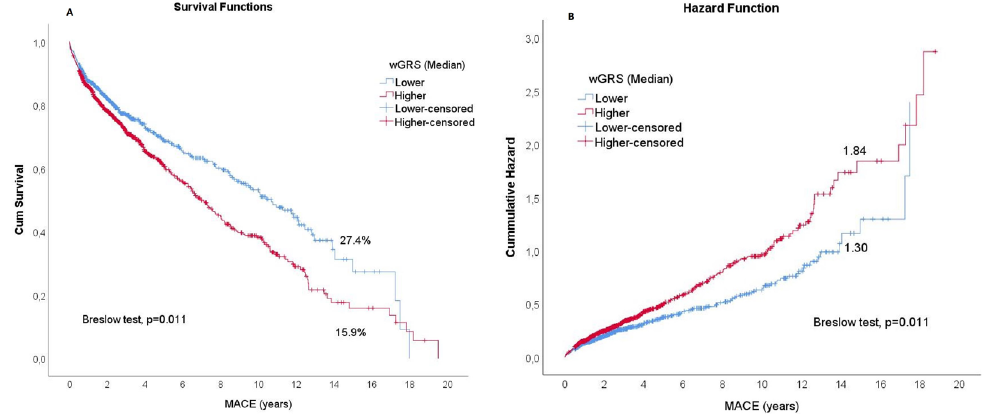
Figure 4 ‒ Survival analysis for patients with and without MACE, comparing wGRS above and below the median. (A) Cumulative survival curves: Lower- and higher-censored data are the individuals who, at the time of follow-up, didn’t develop any type of MACE in each wGRS categories (Lower and higher than median). (B) Cumulative hazard curves: Lower- and higher-censored data are the individuals who, at the time of follow-up, didn’t develop any type of MACE in each wGRS categories (Lower and higher than